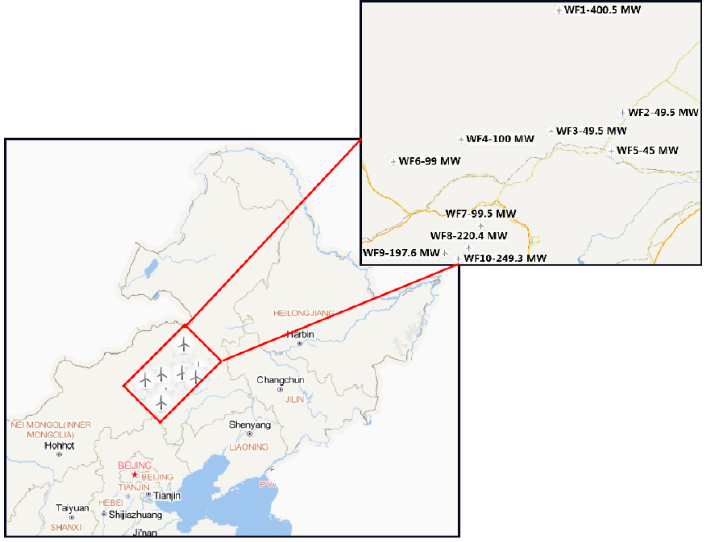
Figure 2. The geographical distribution and rated installed capacity of some wind farms in northeast China.